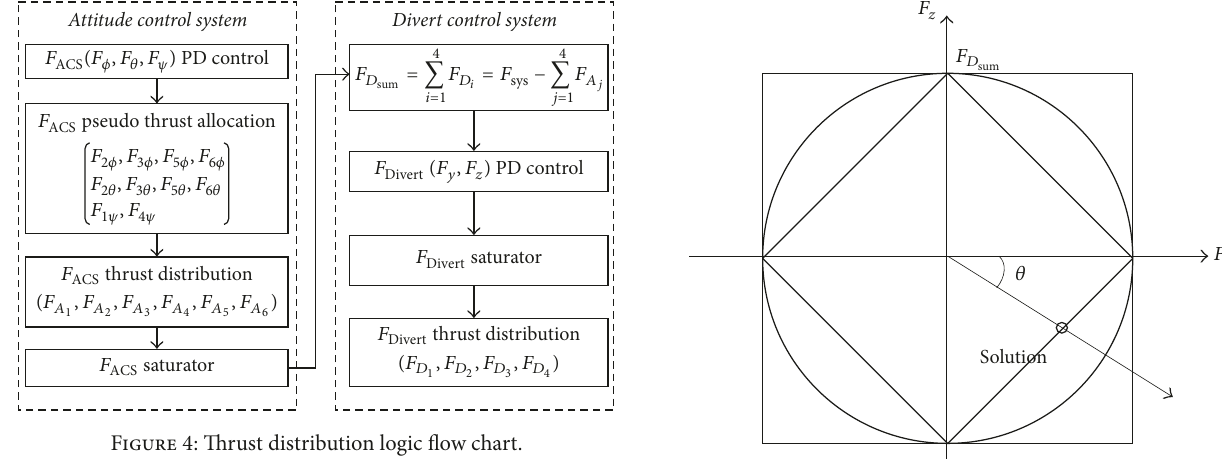
Figure 4: Thrust distribution logic flow chart.